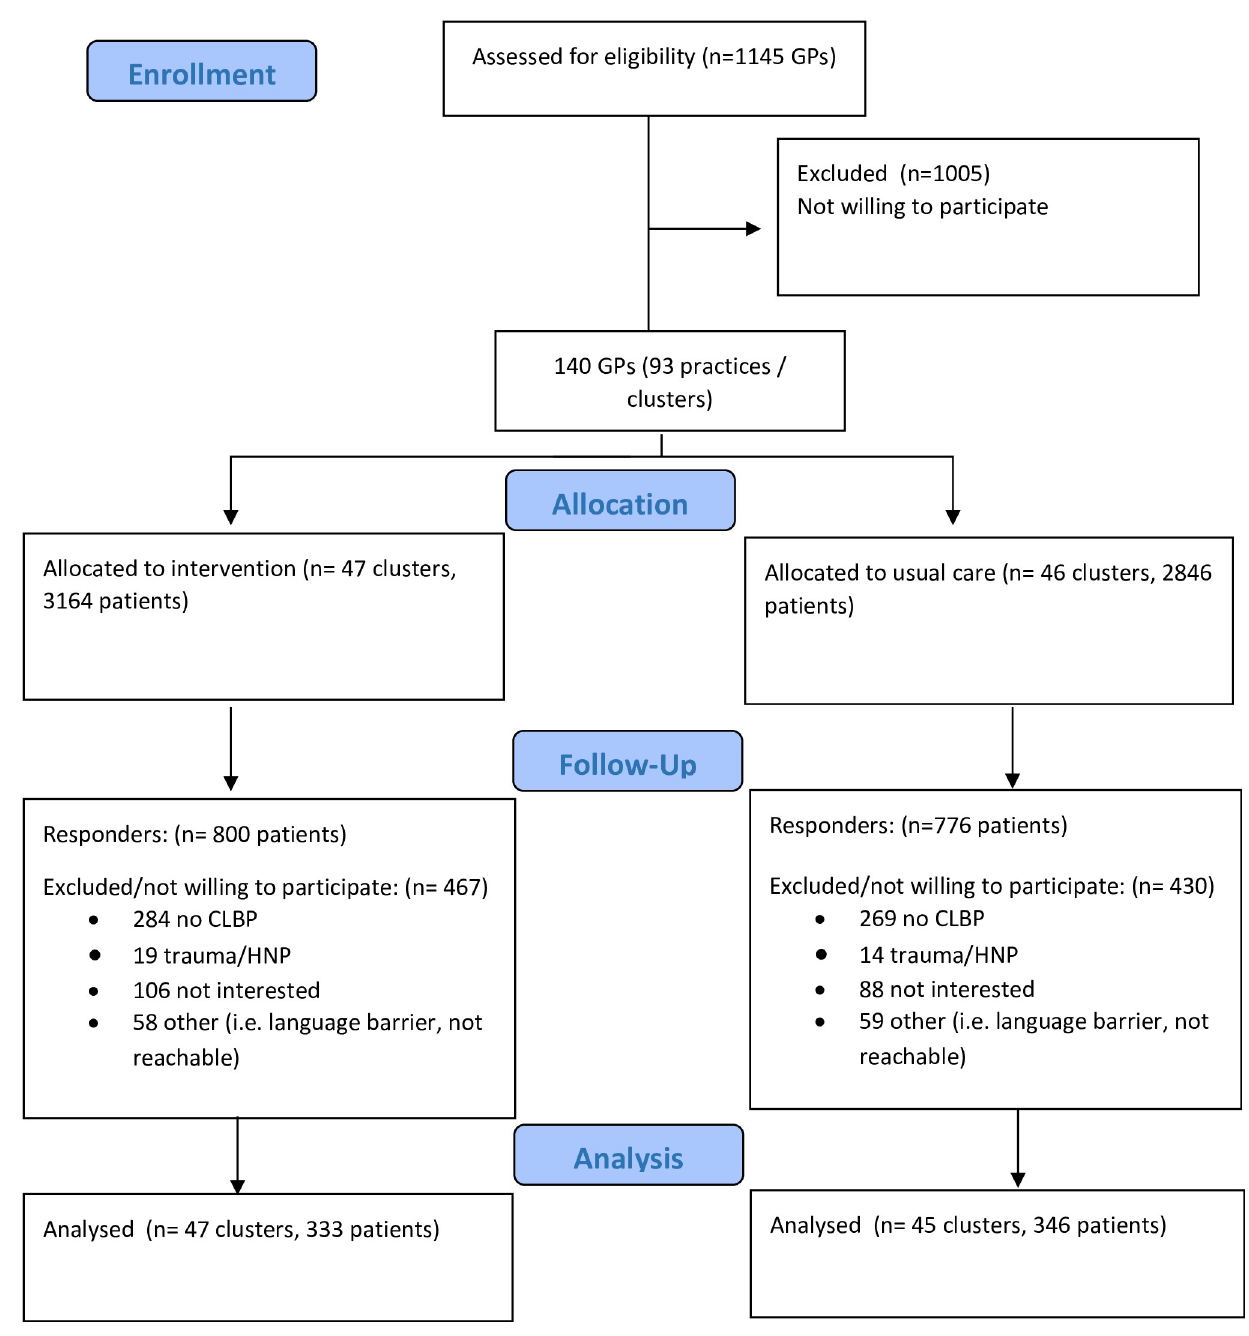
Fig 1. Recruitment flowchart impact